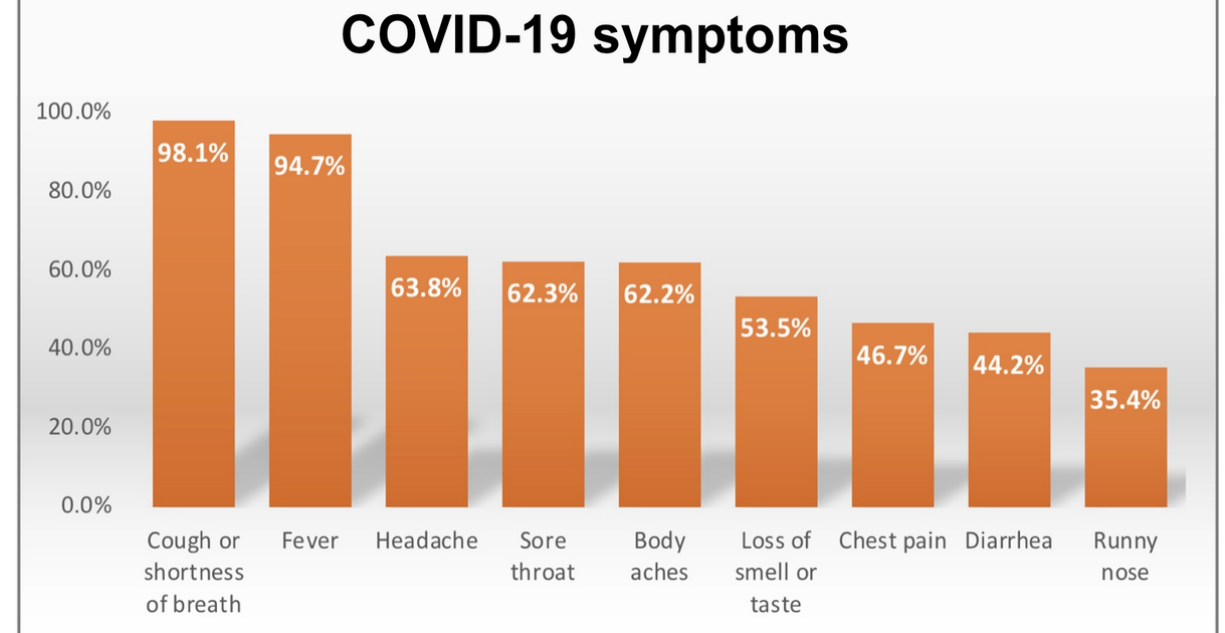
Figure 1. Knowledge of COVID-19 symptoms among health care workers in Saudi Arabia